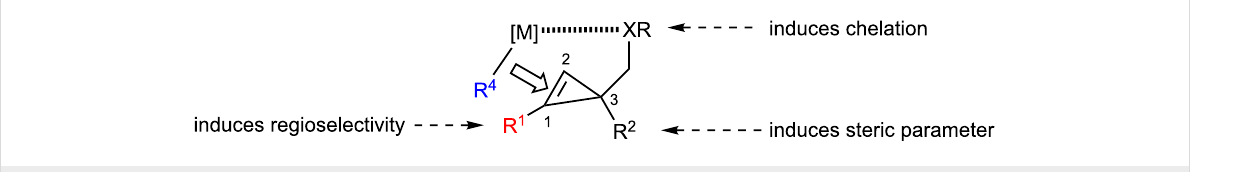
Figure 1: Prerequisite for a regio- and diastereoselective